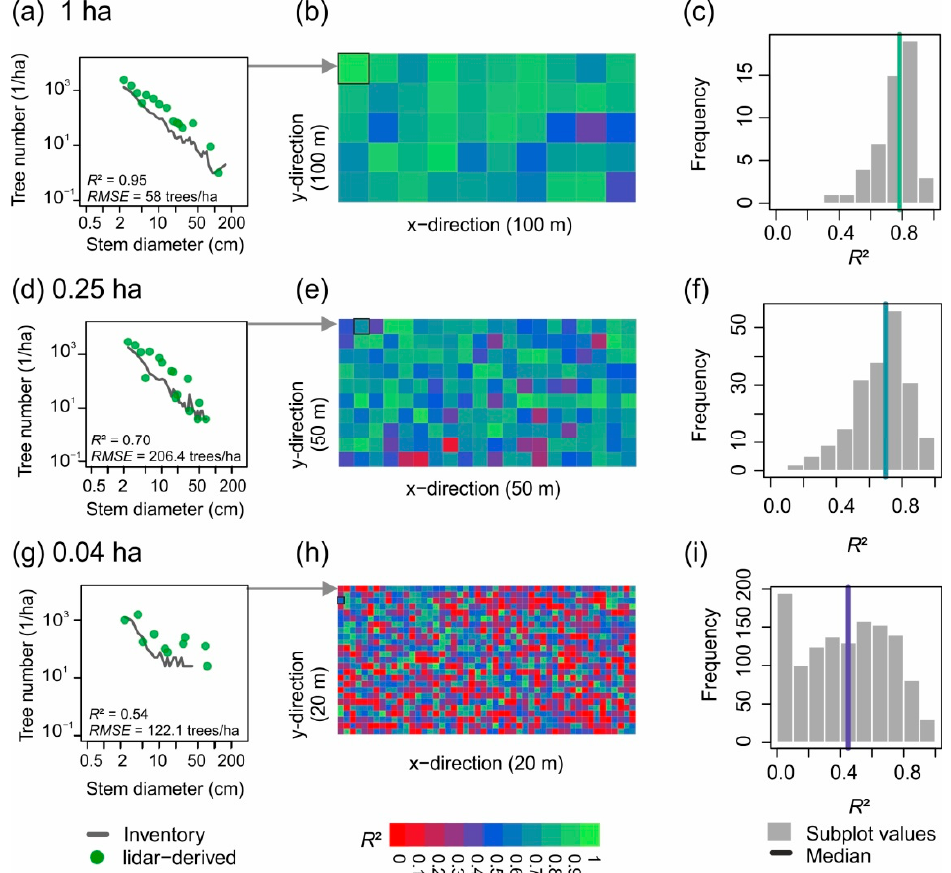
Figure 4. Stem diameter distributions derived from lidar for scales of 1, 0.25, and 0.04 ha. ( a ) An exemplary 1-ha plot of the BCI forest is illustrated by comparing the stem diameter distribution from inventory (grey line) with that derived from lidar (green points). ( b ) Map of BCI divided in 1-ha subplots and colored according to R 2 values. Values close to one (green) show a good estimation. The exemplary plot shown in ( a ) is highlighted with a black border. ( c ) Histogram of R 2 values for all subplots of 1 ha (the vertical line shows the median). Similar analysis is shown in ( d – f ) for the 0.25-ha scale and in ( g – i ) for the 0.04-ha scale. An analysis of the regression slope, RMSE and nRMSE values is shown in Table 3 and Figure A4. Table 3. Comparison of forest attributes derived from lidar and from the forest inventory for different plot sizes. Results are shown for the regression analysis (slope and R ²), RMSE and nRMSE (overall and for three different categories of small, mid-sized and large trees grouped according to stem diameter d ) and aggregated forest attributes (tree density and basal area, for stem diameter d ≥ 10 cm). For each plot size, the mean ± standard deviation (and in brackets, minimum and maximum) of the respective attribute is given. The plot size is given in ha with the number of plots and plot dimension in m × m. Forest attributes are compared between lidar and inventory also in terms of the bias , RMSE , and nRMSE (%) (see methods for details). See Table A2 for additionally analyzed plot sizes.